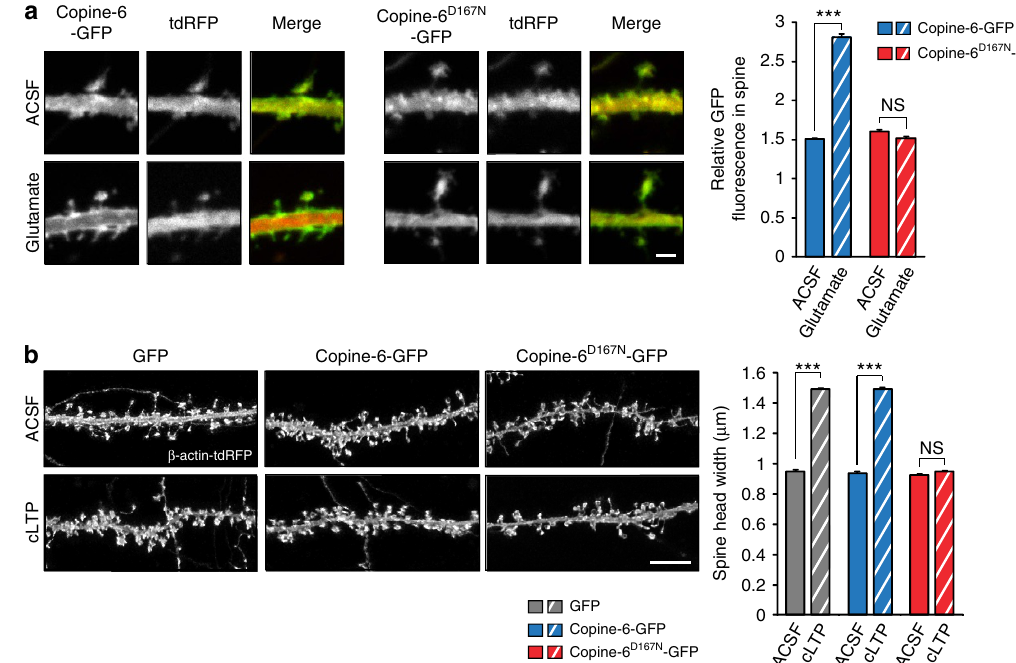
Figure 4 | The calcium Copine-6 D167N mutant does not translocate into spines and inhibits spine structural plasticity. ( a ) DIV14 hippocampal cultures, which had been co-transfected at DIV7 with constructs encoding Copine-6-GFP or Copine-6 D167N -GFP together with tdRFP were incubated for 5min in ACSF or ACSF supplemented with 100 m M glutamate and 10 m M glycine (glutamate). Right: quantification of the relative GFP intensity in spines after normalization to tdRFP. Data are mean ± s.e.m. from n ¼ 500 spines per condition (25 spines per neuron from 20 neurons of each condition; from 3 independent cultures). *** P o 0.001; NS, nonsignificant. P 4 0.05 by one-way ANOVA with Tukey’s post-hoc test. Scale bar, 2 m m. ( b ) DIV21 hippocampal cultures, which had been transfected at DIV14 with constructs encoding Copine-6-GFP or Copine-6 D167N -GFP together with b -actin-tdRFP. Cultures were incubated with ACSF or cLTP-inducing ACSF (cLTP) for 10min and analysed after additional 40min. Left: representative pictures of b -actin-tdRFP fluorescence and GFP fluorescence. Right: quantification of spine head width. It is noteworthy that expression of Copine-6 D167N -GFP abrogates the increase in spine head width seen in GFP- and Copne-6-GFP-expressing neurons on induction of cLTP. Data are mean ± s.e.m. from n ¼ 1,000 spines per condition (50 spines per neuron from 20 neurons of each condition; from 3 independent cultures). *** P o 0.001; NS. P 4 0.05 by one-way ANOVA with Tukey’s post-hoc test. Scale bar, 10 m